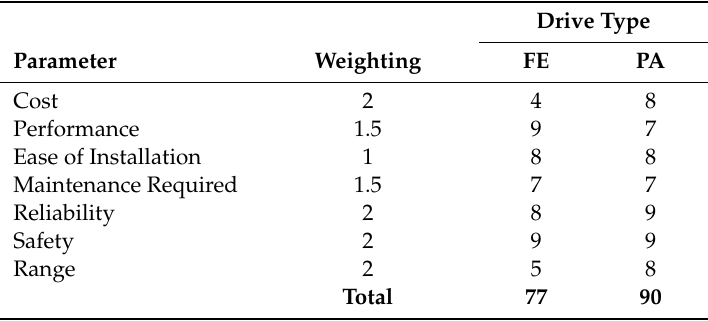
Table 3. Drive selection